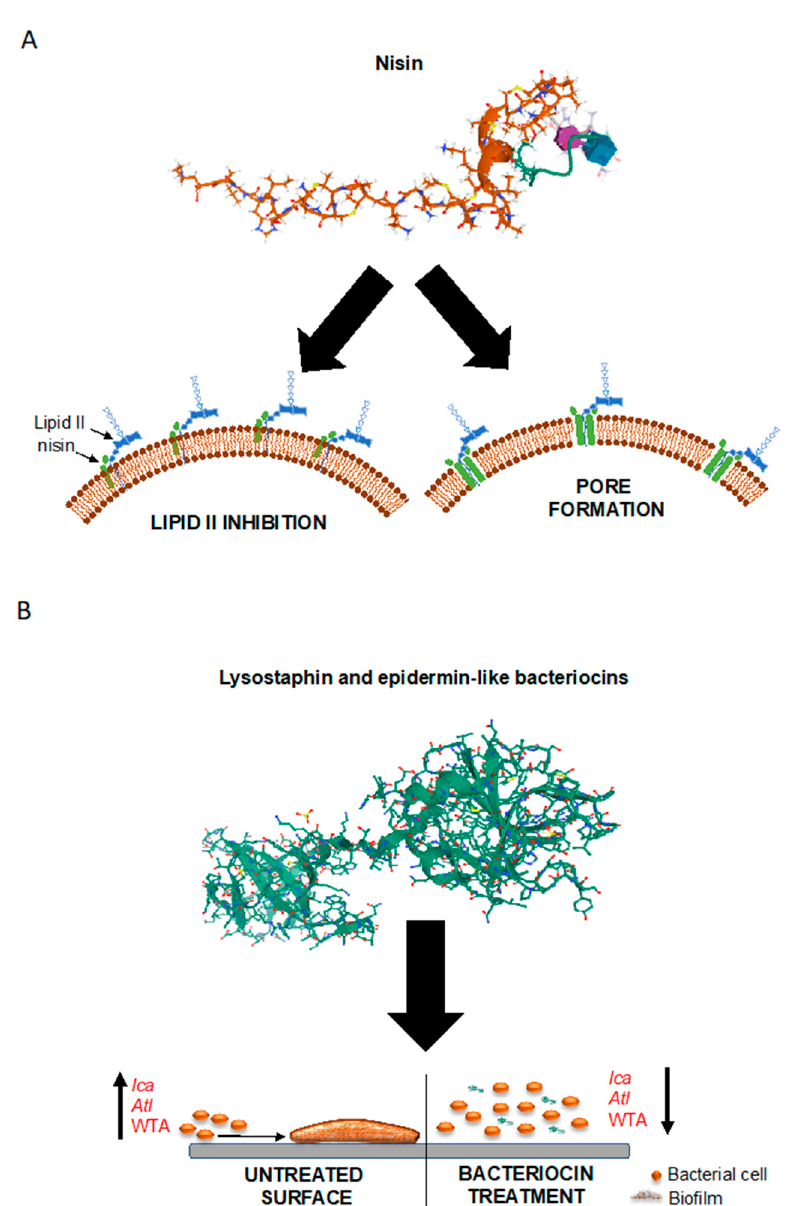
Figure 2. Model of anti-biofilm and bactericidal action of bacteriocins. ( A ) The structure of nisin in conjugation with lipid II is shown along with a representation of its dual mechanism of action. By interacting with lipid II molecules exposed on the cell surface, the bacteriocin inhibits the cell-wall biosynthesis and leads to pore formation in the bacterial cell membrane. ( B ) The structure of lysostaphin is shown as a representative example of staphylococcins. Its anti-biofilm action relies in part on the perturbation of wall teichoic acid (WTA), the function of which has been shown to be important in the process of biofilm formation. Epidermin-like bacteriocins (e.g., epidermin and gallidermin) follow a similar mode of action, and also lead to the downregulation of biofilm-promoting genes such as ica and atl . The protein structures were obtained from the Research Collaboratory for Structural Bioinformatics (RCSB) Protein Data Bank (PDP) (http://www.rcsb.org). An important aspect linked to the use of bacteriocins as antimicrobial agents is their synergistic effect with antibiotics or other classes of bactericidal drugs. The advantages of this combinatorial strategy are several. Synergistic interactions between antimicrobials